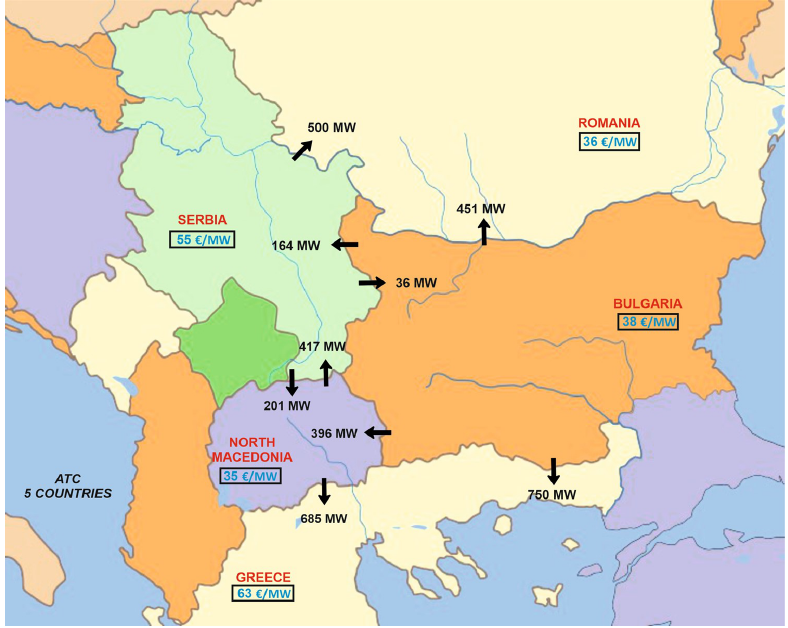
Figure 2. Cross-border trading with the ATC method for the five countries.